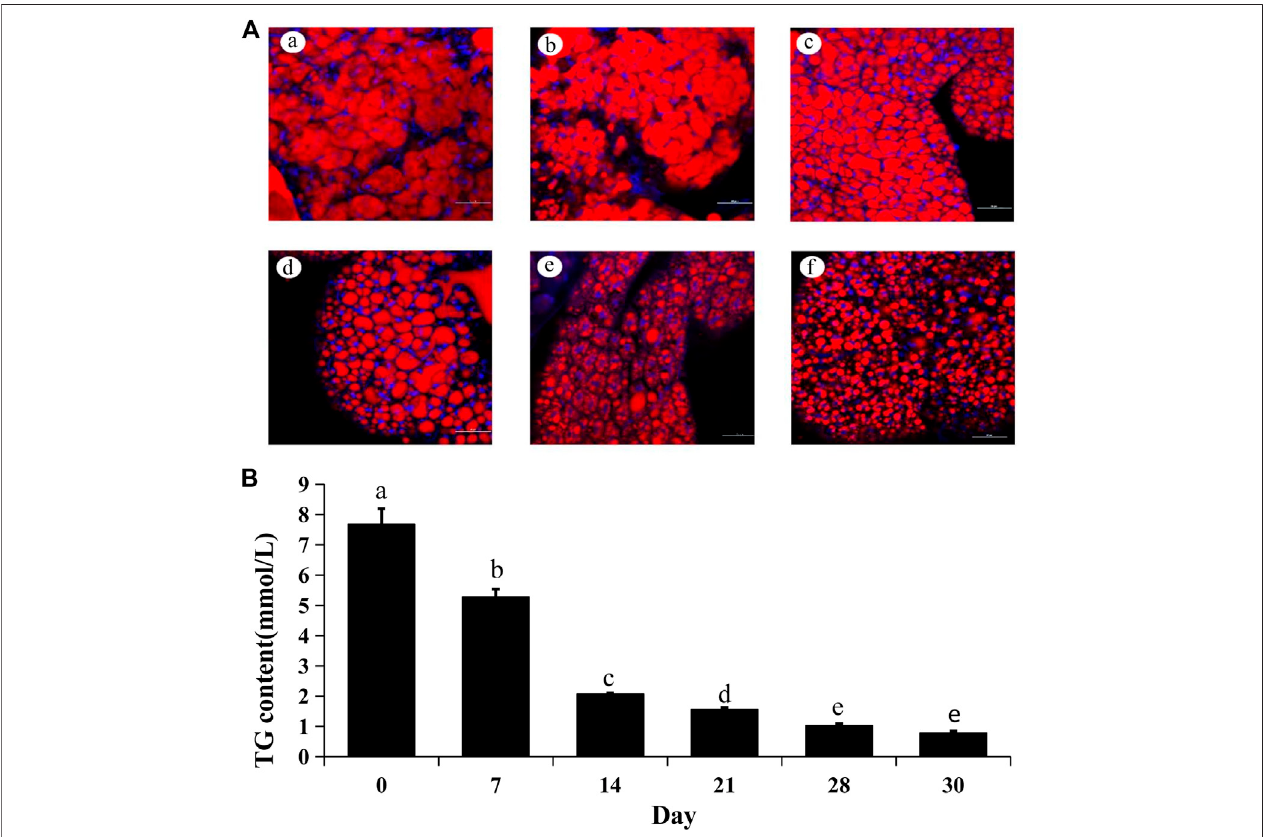
FIGURE4| LipidchangesafterJHIIIinjectioninthefatbodyof A.chinensis . (A) NileRedstainingoffatbodyafterJHIIIinjection.a,0thday;b,7thday;c,14thday;d, 21st day; e, 28th day; f, 30th day. Red signal indicates the lipid droplets stained by Nile Red, and blue signal indicates the nucleus stained by DAPI. (B) Triglyceride (TG) contents. The different lowercase letters above bar are signi fi cant difference at p < 0.05 (one-way ANOVA followed by Duncan ’ s multiple comparison).